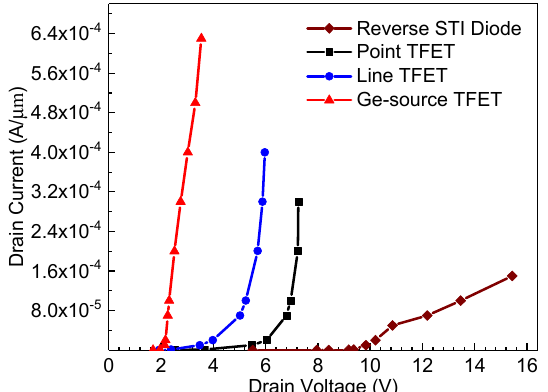
Figure 5. Simulated transmission line pulsing (TLP) curves of different TFETs and the reverse shallow-trench-isolation (STI) diode.